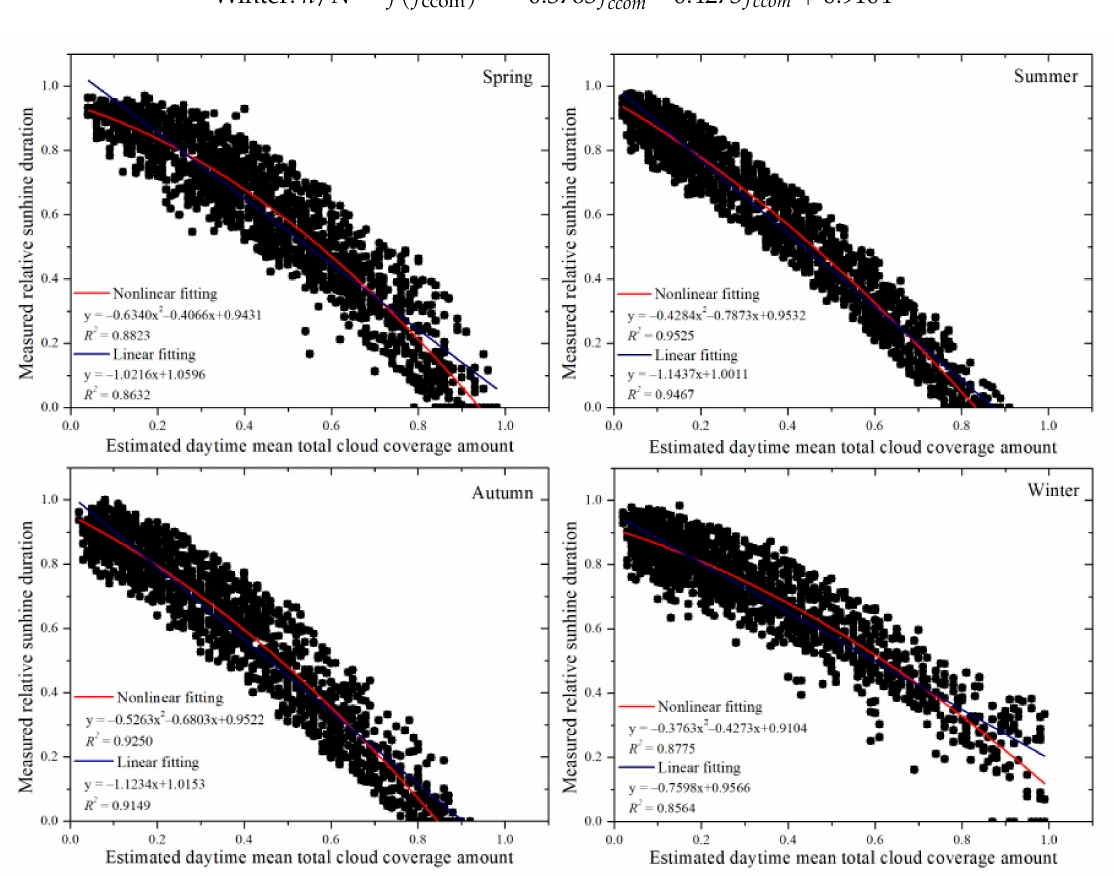
Figure 3. Relationship between daytime mean total cloud coverage amount and relative sunshine duration for 18 meteorological stations by season for 2017 and